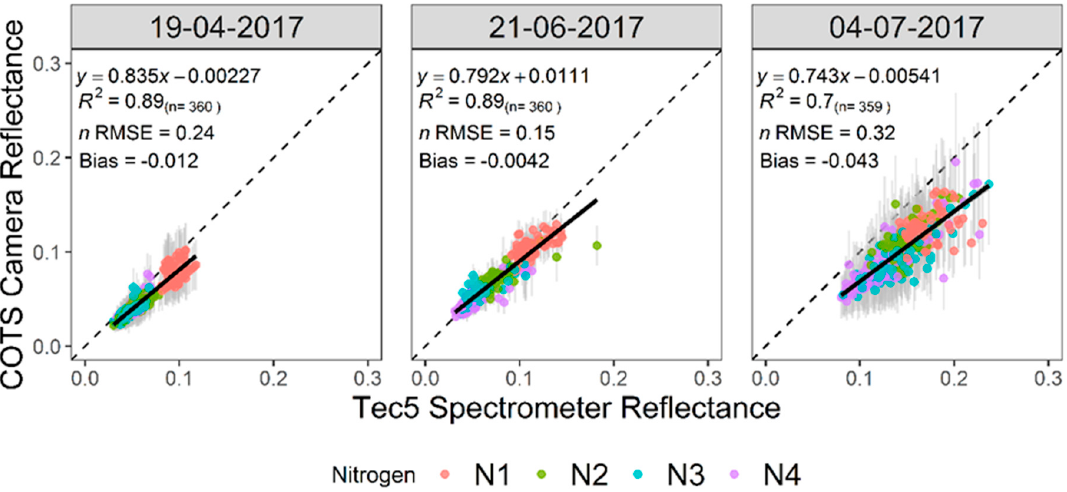
Figure 13. Accuracy assessments of red band reflectance for three dates. Tec5 reflectance is convolved to the spectral response of the COTS cameras for comparison. The points are coloured based on nitrogen treatment applied to the plot. Standard deviation of reflectance measured by the COTS cameras is presented by vertical error bars. The dashed line represents the 1:1 line.